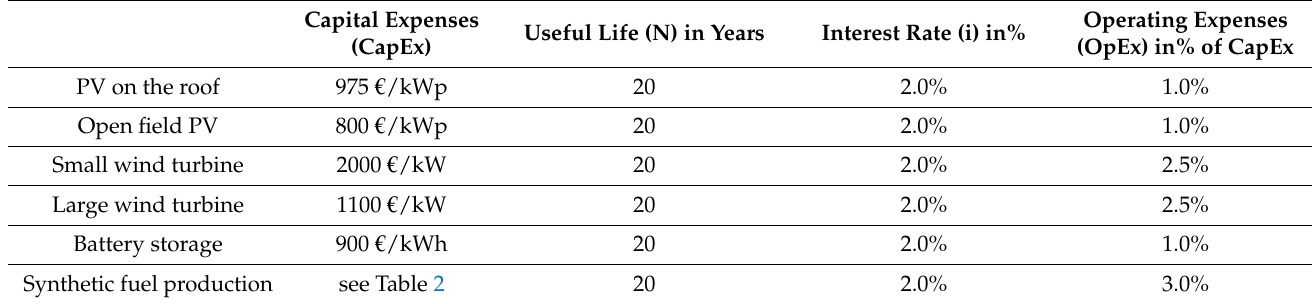
Figure 5. Schematic representation of the provision of synthetic diesel [27]. Table 1. Costs for systems for energy generation, storage and conversion.